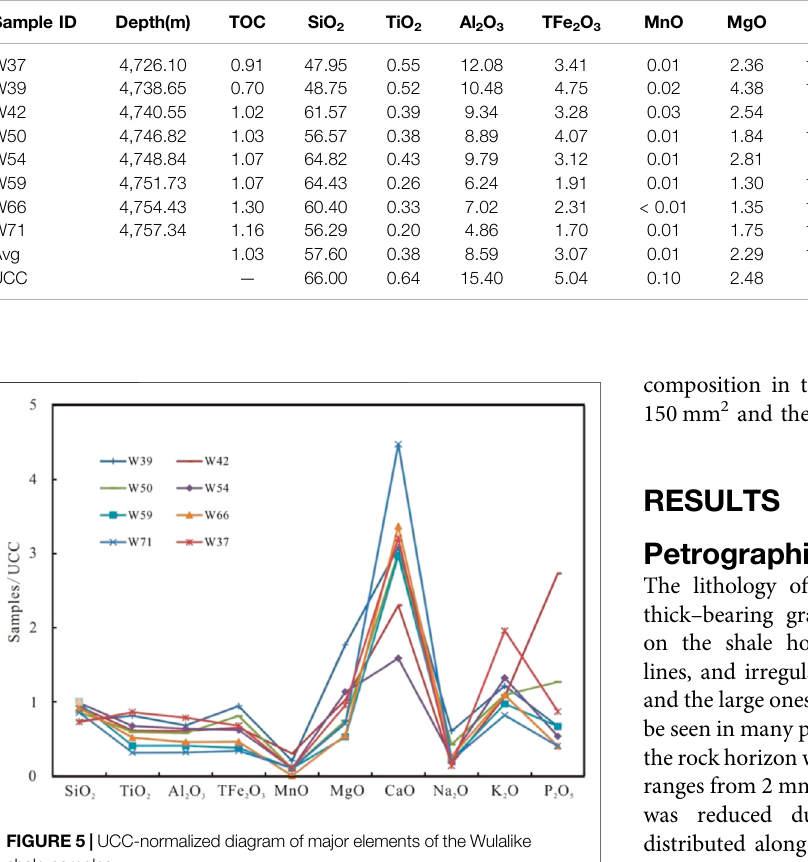
FIGURE 5 | UCC-normalized diagram of major elements of the Wulalike shale samples.